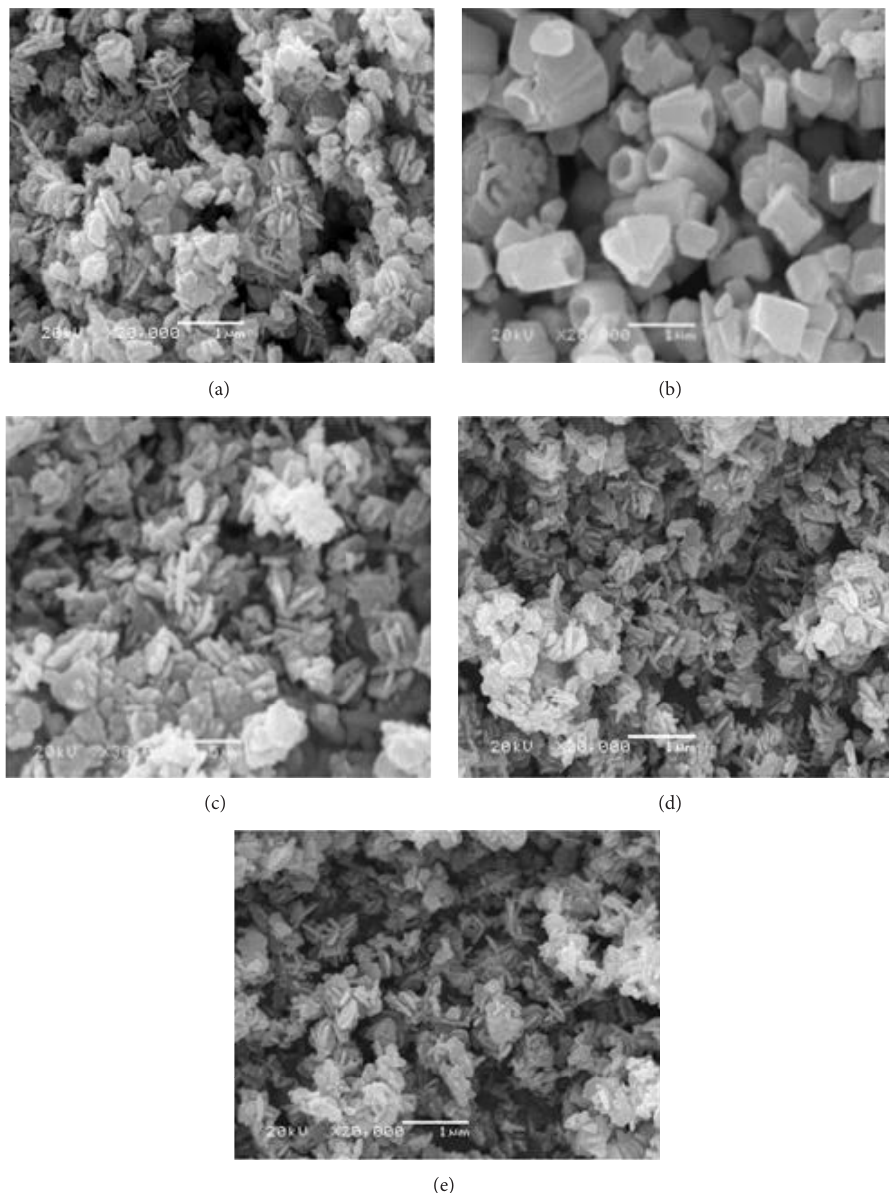
Figure 10: SEM micrographs of ZnO prepared using hydrothermal technique with different surfactant agents: (a) PVP, (b) PVA, (c) CTAB, (d) TEA, and (e)